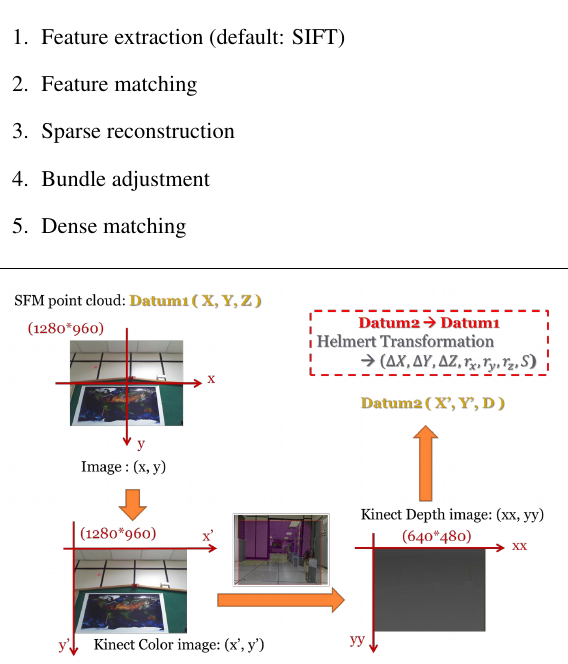
Algorithm 1 General procedure of VisualSFM